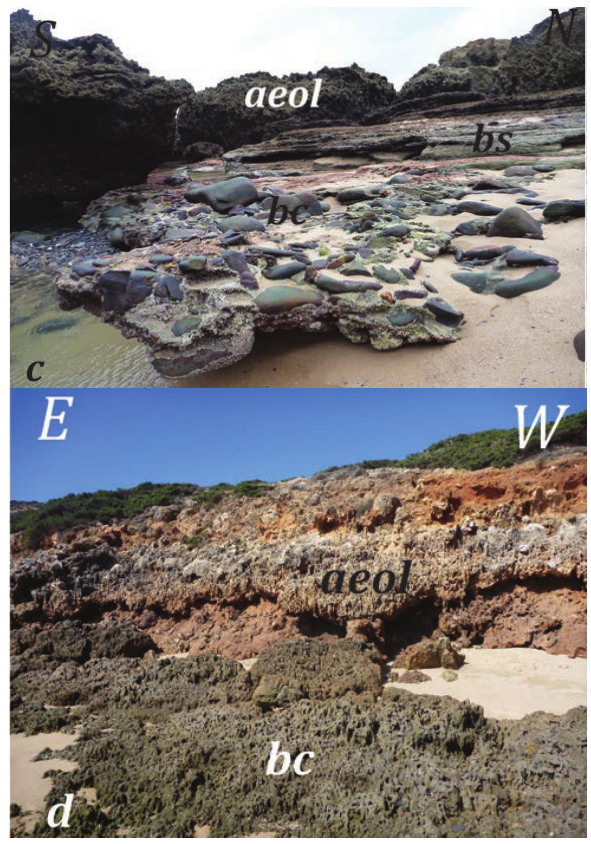
Figure 3 (counterclockwise from down left). The modern abrasion platform is reoccupying an older one at several sites in the southwest Portuguese coastline. All of these sites share the same sedimentary sequence, and the paleo-shorelines are at the same elevation. a) Per- spective at Amoreira beach; in the background the abrasion platform is cut into schists. Overlying the abrasion platform (p), now reoccu- pied by the nowadays sea level are basal coarser sediments (bc) and ae- olianites (aeol), with a notch (n) developed at the back edge. b) Another perspective from Amoreira beach, aeolianites (aeol) on top of basal coarser sediments (bc). c) Castelejo beach, coarser basal sed- iment (bc), interbedded with medium to fine sand, overlying an abra- sion platform (not visible in this image, covered by modern beach sand) and underlying aeolianites (aeol); d) Bordeira beach, basal coarser sediments (bc), underlying several aeolianite (aeol)